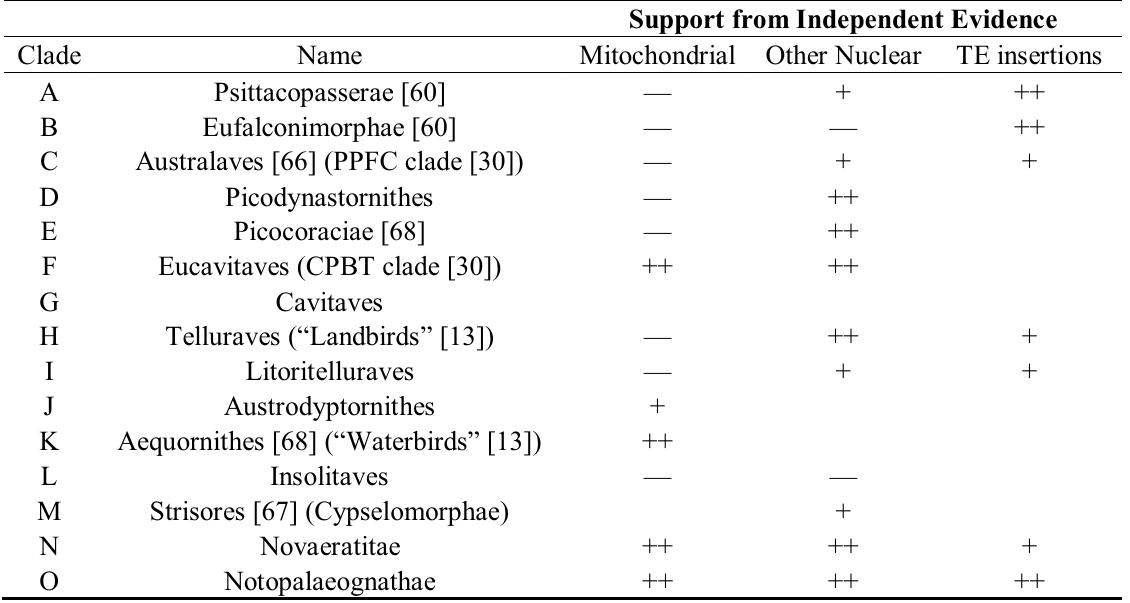
Table 1. Supra-ordinal clades in the Early Bird tree and their corroboration by independent evidence (from mitogenomics [28,59], analyses of nuclear regions [30,31,63,64] that were not used by Hackett et al . [13] and transposable element (TE) insertions [60 (cid:177) 62]). Strong (cid:70)(cid:82)(cid:85)(cid:85)(cid:82)(cid:69)(cid:82)(cid:85)(cid:68)(cid:87)(cid:76)(cid:82)(cid:81)(cid:3)(cid:11)(cid:69)(cid:82)(cid:82)(cid:87)(cid:86)(cid:87)(cid:85)(cid:68)(cid:83)(cid:3)(cid:86)(cid:88)(cid:83)(cid:83)(cid:82)(cid:85)(cid:87)(cid:3)(cid:149)(cid:26)(cid:19)(cid:8)(cid:3)(cid:82)(cid:85)(cid:3)(cid:149)(cid:22)(cid:3)(cid:55)(cid:40) insertions) was indicated using (cid:179)(cid:14)(cid:14)(cid:180) and moderate corroboration (presence of the clade in with bootstrap support <70% or 1 (cid:177) 2 TE i (cid:81)(cid:86)(cid:72)(cid:85)(cid:87)(cid:76)(cid:82)(cid:81)(cid:86)(cid:12)(cid:3) (cid:90)(cid:68)(cid:86)(cid:3) (cid:76)(cid:81)(cid:71)(cid:76)(cid:70)(cid:68)(cid:87)(cid:72)(cid:71)(cid:3) (cid:88)(cid:86)(cid:76)(cid:81)(cid:74)(cid:3) (cid:179)(cid:14)(cid:180) . Blank cells indicate that the available